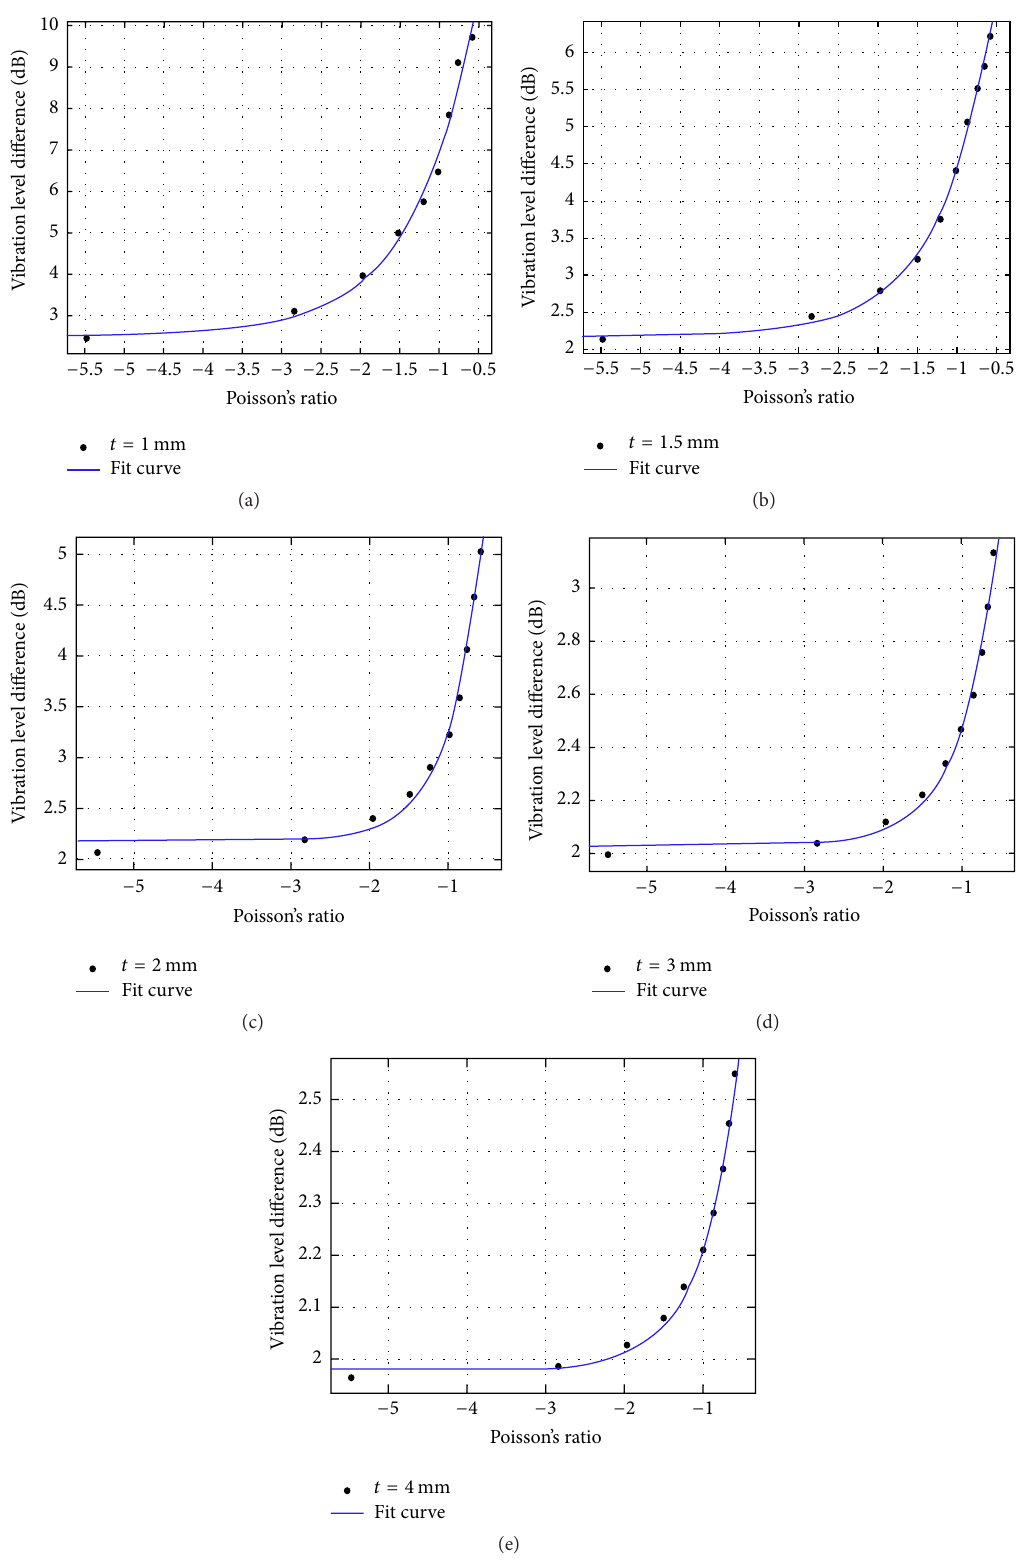
Figure 7: Acceleration vibration level difference of auxetic cellular base variation against Poisson’s ratio for different values of the cell thickness: (a) 𝑡 = 1 mm, (b) 𝑡 = 1.5 mm, (c) 𝑡 = 2 mm, (d) 𝑡 = 3 mm, and (e) 𝑡 = 4